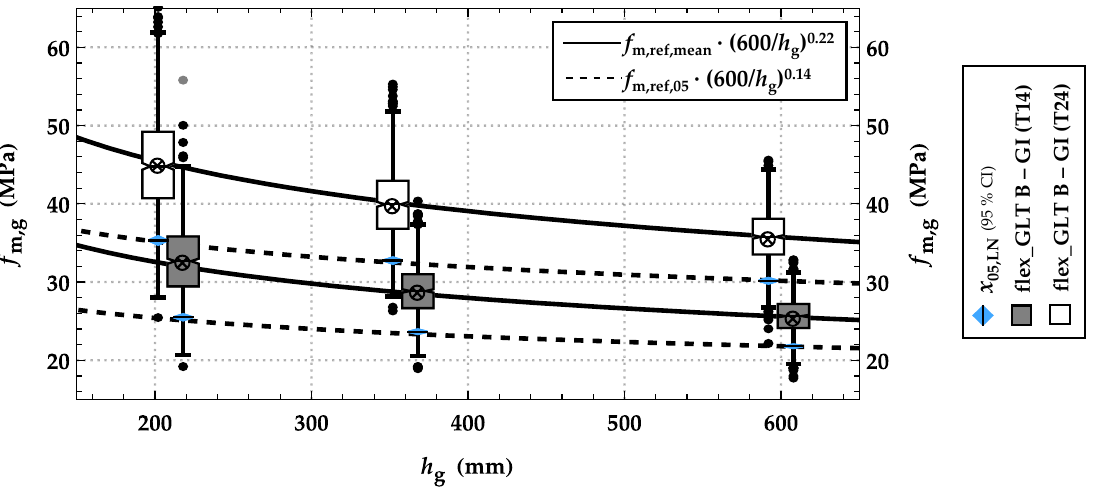
Figure 30. Boxplots together with mean and 5%-quantile values of the bending strength f m,g for flex_GLT type B beams, featuring a width of w g = 150 mm and various beam depths ( h g = {210; 360; 600} mm), built up from boards of group GI (T14) and GII (T24) with dimensions w b = 100 mm and t b = 30 mm.